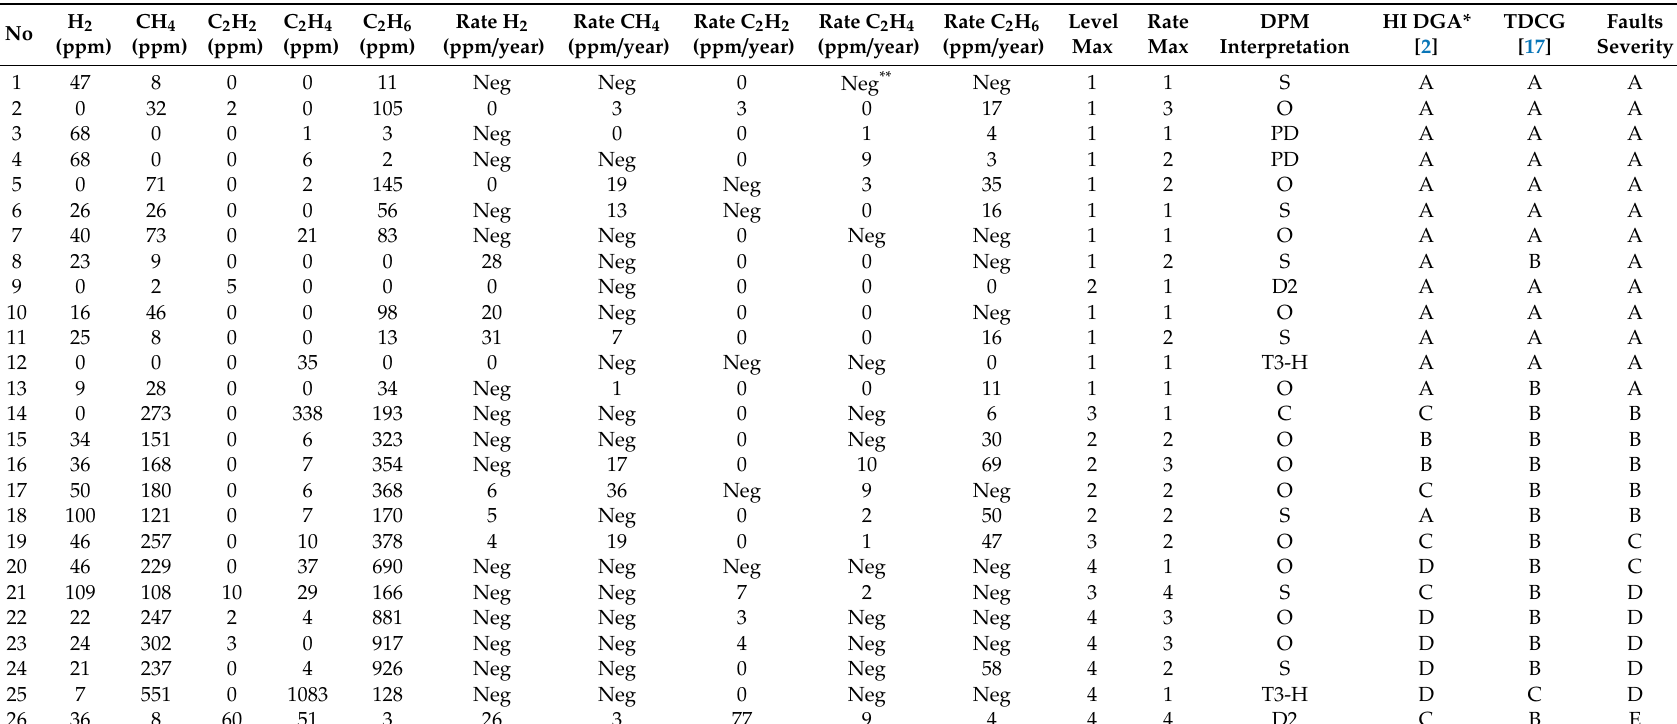
Table 13. Sample of 26 power transformers’ faults’ severity